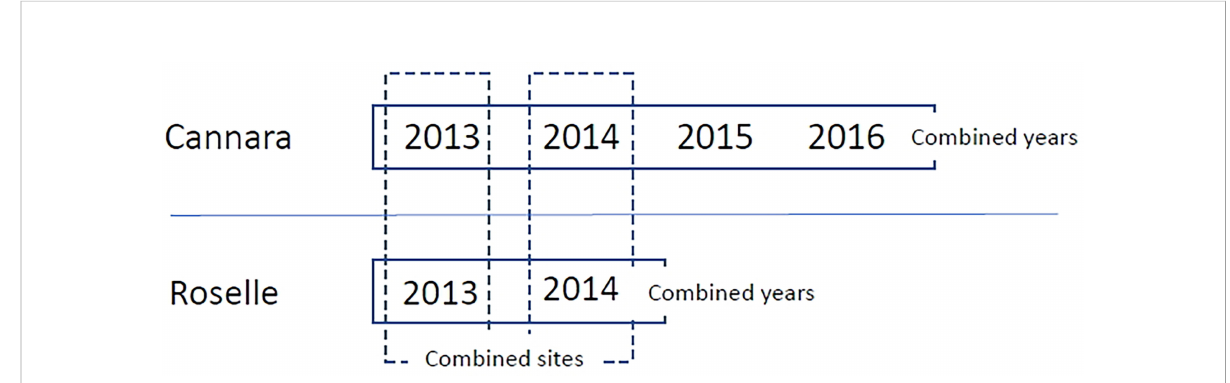
FIGURE 1 Scheme of ANOVA analysis followed for combined environments. For both sites, each year represents a single environment. So, there are 4 environments in Cannara and 2 in Roselle. From the combination of site per year we obtain a total of 6 environments. For each of the two sites, combined analyzes were carried out for years (represented by rectangles with solid lines) to study the variations of clones in different years in the same site. While between the two sites, combined analyzes were carried out in 2013 and 2014 (represented by the dashed rectangles) to study the effect of the site in two different